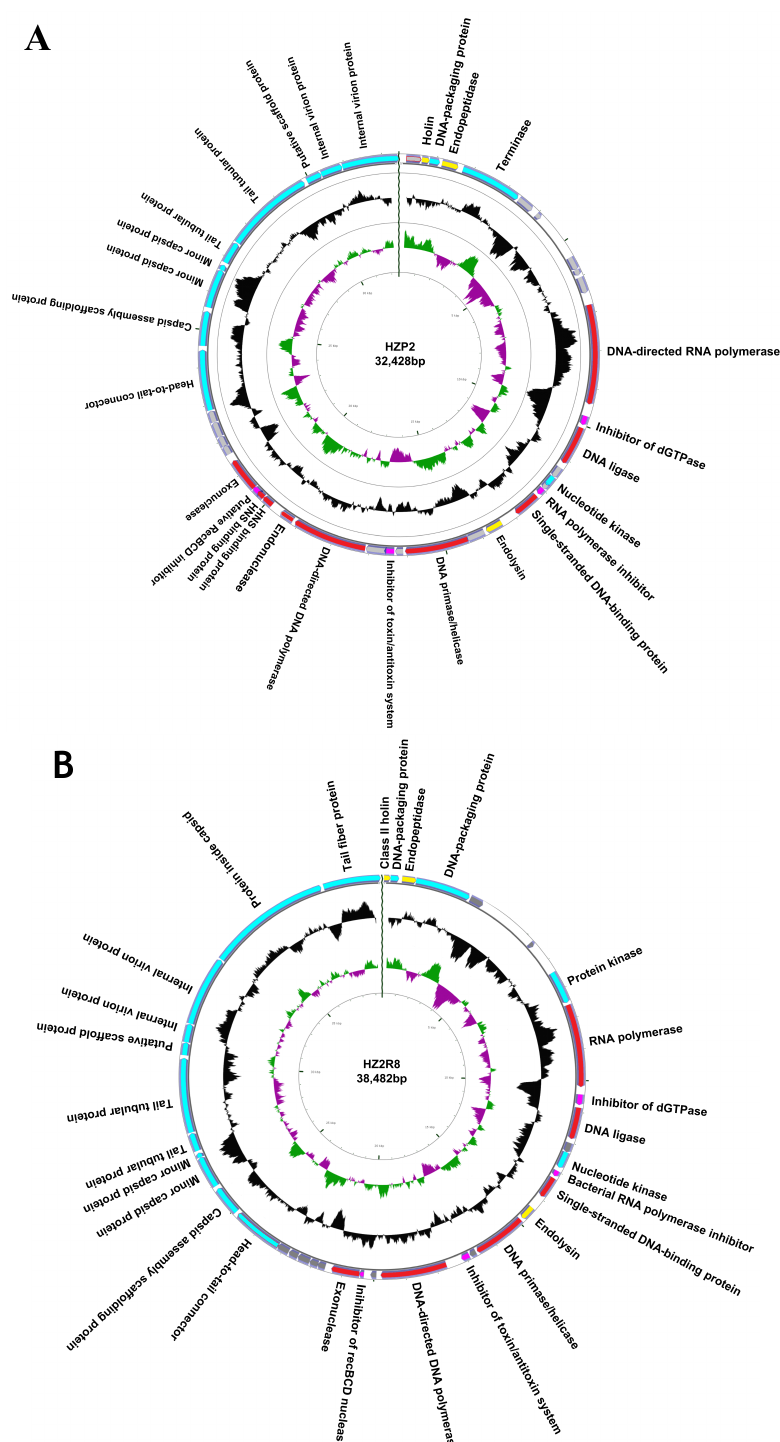
Figure 3. Map of the genome organization of phage HZP2 ( A ) and HZ2R8 ( B ). Di ff erent colors in the first circle represented putative open reading frames (ORFs) with di ff erent functions. Red represented DNA replication and regulation modules, blue represented packaging and structural modules, yellow represented lysis modules, pink represented host function inhibition modules, and gray represented hypothetical proteins modules. The second circle showed the G / C content: outward indicated that the G / C content of the region was higher than the average G / C content of the whole genome, and inward indicated that G / C content of the region was less than the average; The third circle showed the GC skew. Green outward indicated the area G > C, and pink inward indicated G <